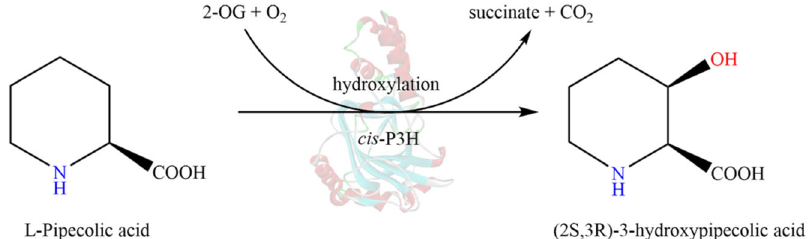
Figure 1. Hydroxylation of L-Pipecolic acid catalyzed by Fe(II)/2-OG-dependent dioxygenase cis ‐ P3H. The involved hydroxyl group was labeled in red; the imino groups were labeled in blue,